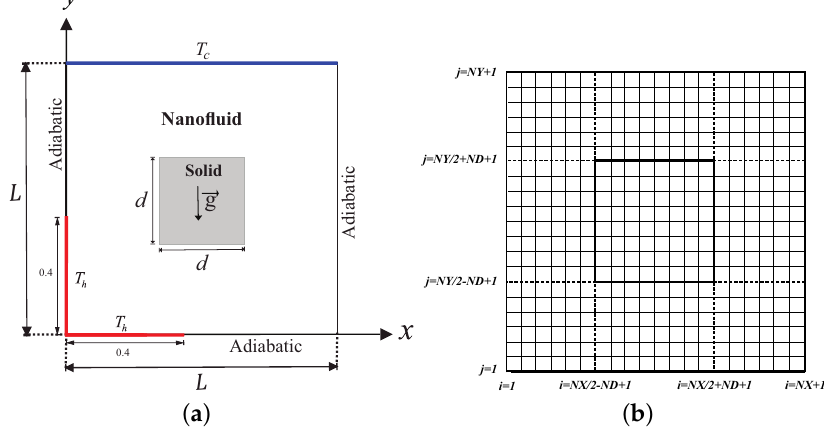
Figure 1. ( a ) Physical model of convection in a square cavity together with the coordinate system, and ( b ) grid-points distribution in the conducting solid block ( NY /2 NX /2 ND + 1 i NX /2 + ND + − ≤ ≤